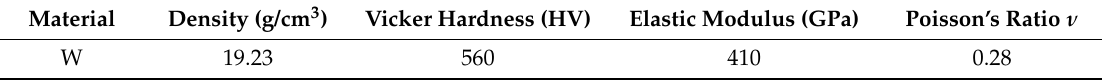
Table 2. Material properties used for weldability window calculation.